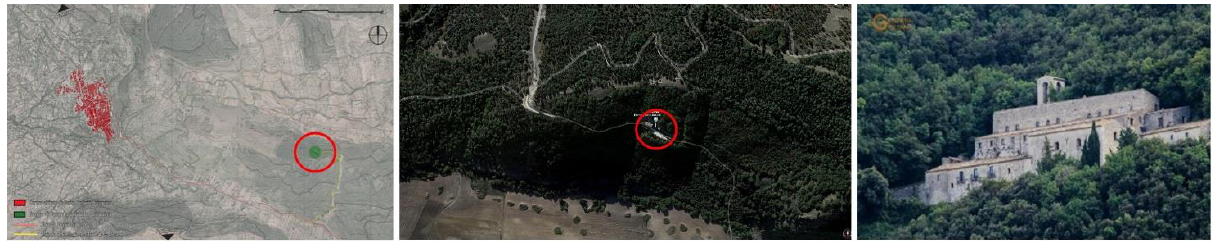
Figure 1. The study site- Eremo di Santa